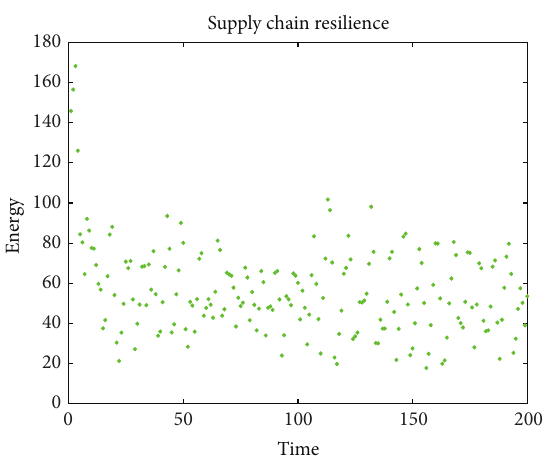
Figure 17: There is no resilience at